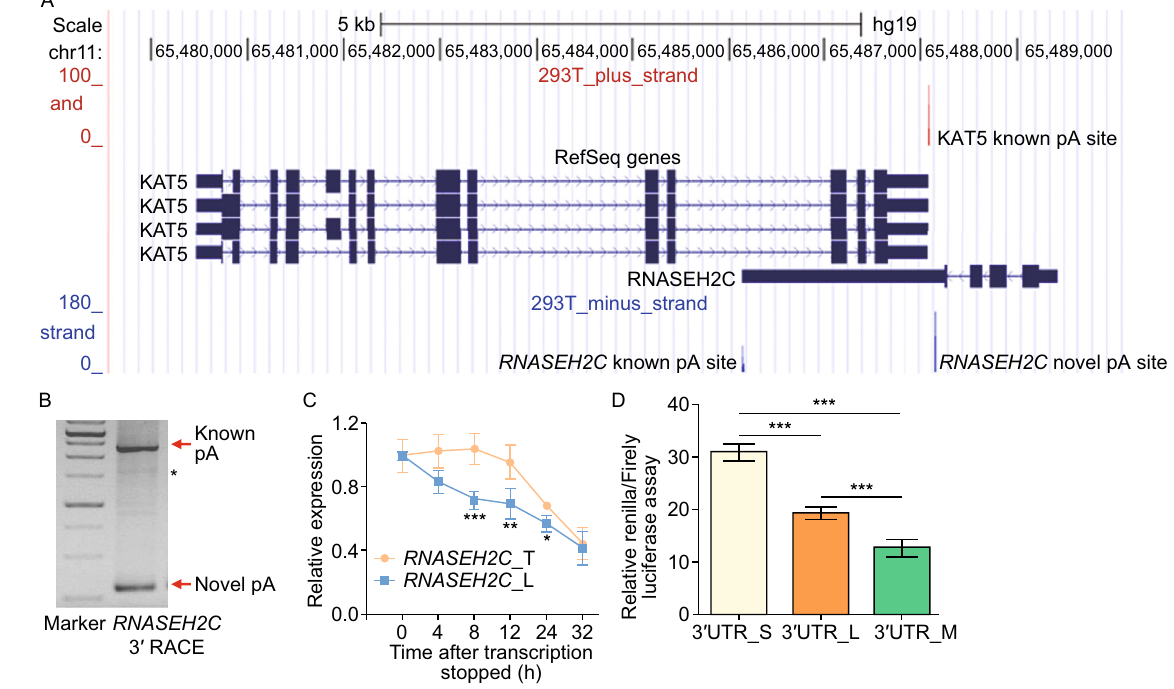
Figure 1. Transcripts of human RNASEH2C gene with shorter 3 ′ UTR generated by a novel pA site is more stable and produces more protein. (A) UCSC genome browser track of pA site signal for RNASEH2C and KAT5 based on PA-seq data in human 293T cells. The red vertical line above denotes pA site signal for KAT5 gene, and the blue lines below denotes that for RNASE2HC gene. (B) 3 ′ RACE result for RNASEH2C . The bands indicated by red arrows were products from the short (novel pA site) and long (known pA site) isoforms, respectively. ‘ * ’ indicated the non-speci fi c ampli fi cation. (C) RNA stability assay using qRT- PCR for the total RNASEH2C transcripts ( RNASEH2C _T) and the isoform with long 3 ′ UTR ( RNASEH2C _L) in 293T cells after blocking transcription with actinomycin D (ActD). (D) Dual luciferase assay for short (S), long (L) and mutant (M) 3 ′ UTR of RNASEH2C . Mutant 3 ′ UTR denoted the long 3 ′ UTR in which the proximal polyadenylation signal ‘ AATAAA ’ was eliminated by mutating to ‘ CAATTG ’ . ***, ** and * represents P value ( t -test) less than 0.001, 0.01 and 0.05,